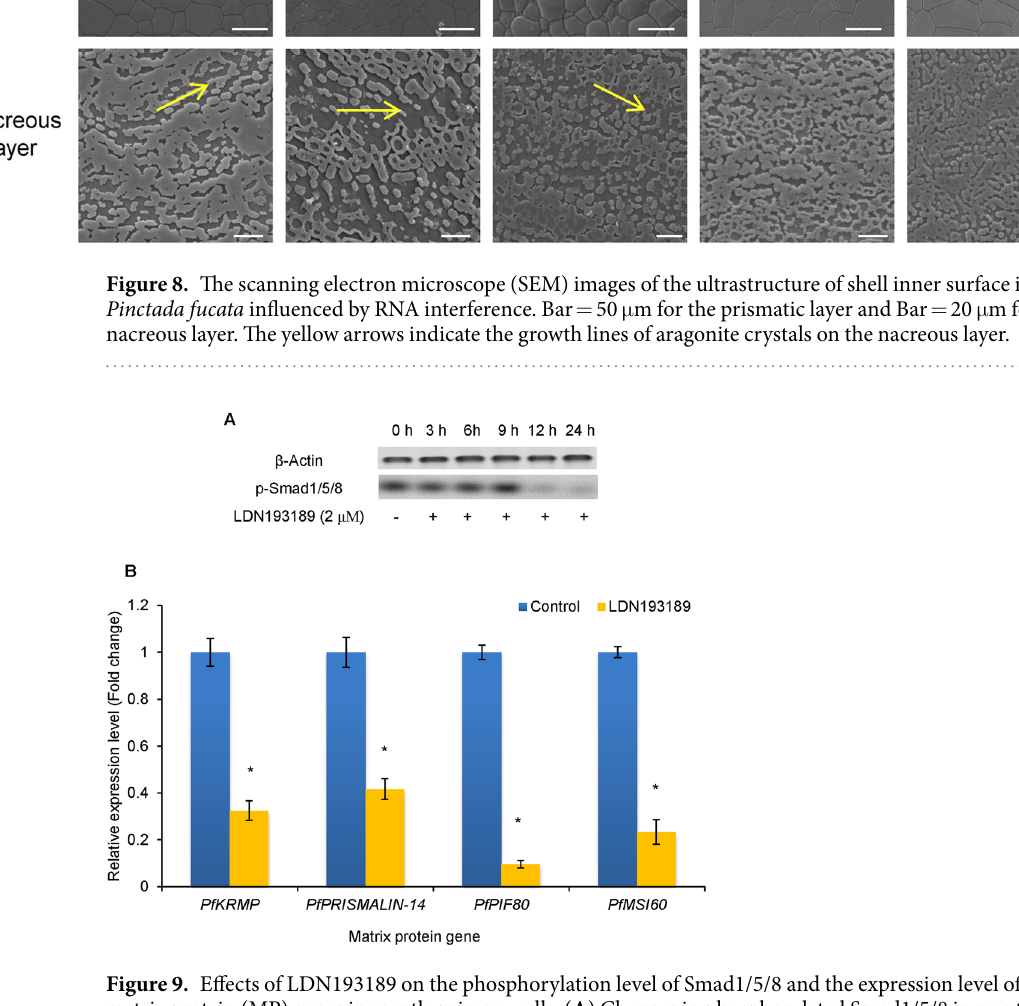
Figure 9. Effects of LDN193189 on the phosphorylation level of Smad1/5/8 and the expression level of matrix protein (MP) genes in mantle primary cells. ( A ) Changes in phosphorylated Smad1/5/8 in mantle cells detected by western blot. p-Smad1/5/8: Phosphorylated Smad1/5/8. β -Actin is used as control. ( B ) The relative expression levels of MP genes in the mantle cells exposed to LDN193189. The expression levels of MP genes in unexposed mantle cells were used as corresponding controls. * P < 0.05. Differences were assessed by one-way